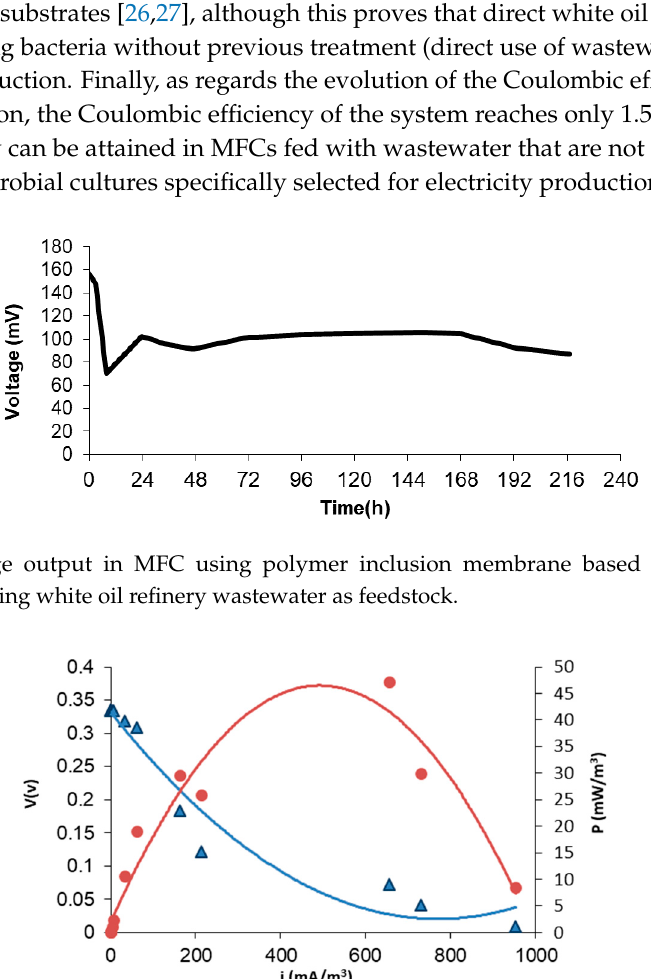
Figure 5. Polarization test of MFCs using white oil industry wastewater as feedstock and a polymer inclusion membrane based on [MTOA + ][Cl − ]. Polarization curve for MFCs (V vs. I). Power output curve (P vs. I). Calculations are based on anode liquid volume.